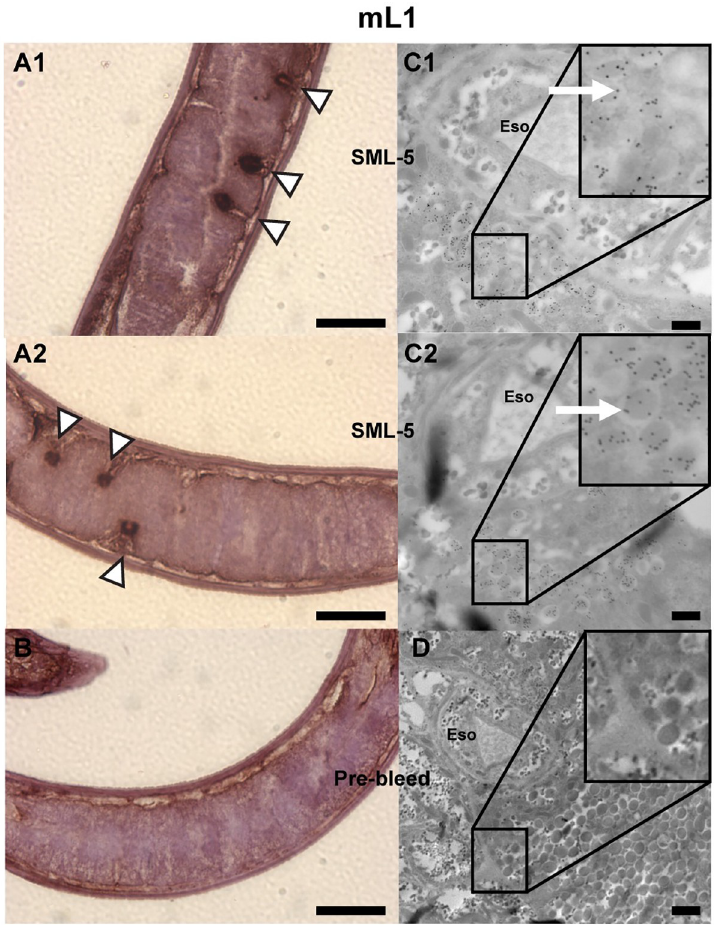
Fig 4. Histochemical and ultrastructural localization of SML-5. (A and B) Formalin-fixed paraffin embedded T . spiralis mL1 probed with anti-SML-5 (A1 and A2) or pre-vaccination control sera (B) and detected with HRP- conjugated anti-IgG and DAB substrate. Sections were counterstained with Mayer’s hematoxylin. The white arrows show areas of staining within specific regions of the mL1 α -stichocytes. (C and D) TEM sections of T . spiralis mL1 were probed with anti-SML-5 (C1 and C2) or pre-vaccination control sera (D) and visualized with goat anti-mouse IgG coupled to 15 nm gold particles (black dots). Localization of SML-5 to a subset of granules adjacent to esophagus can be observed. Eso: Esophagus. Black scale bars in twenty μ m (A and B) and five hundred nm (C and D) are shown in each